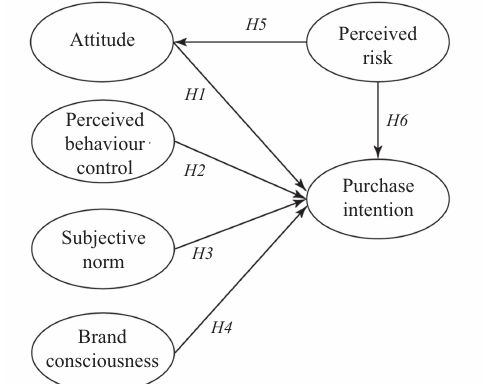
Figure 1. Research model and